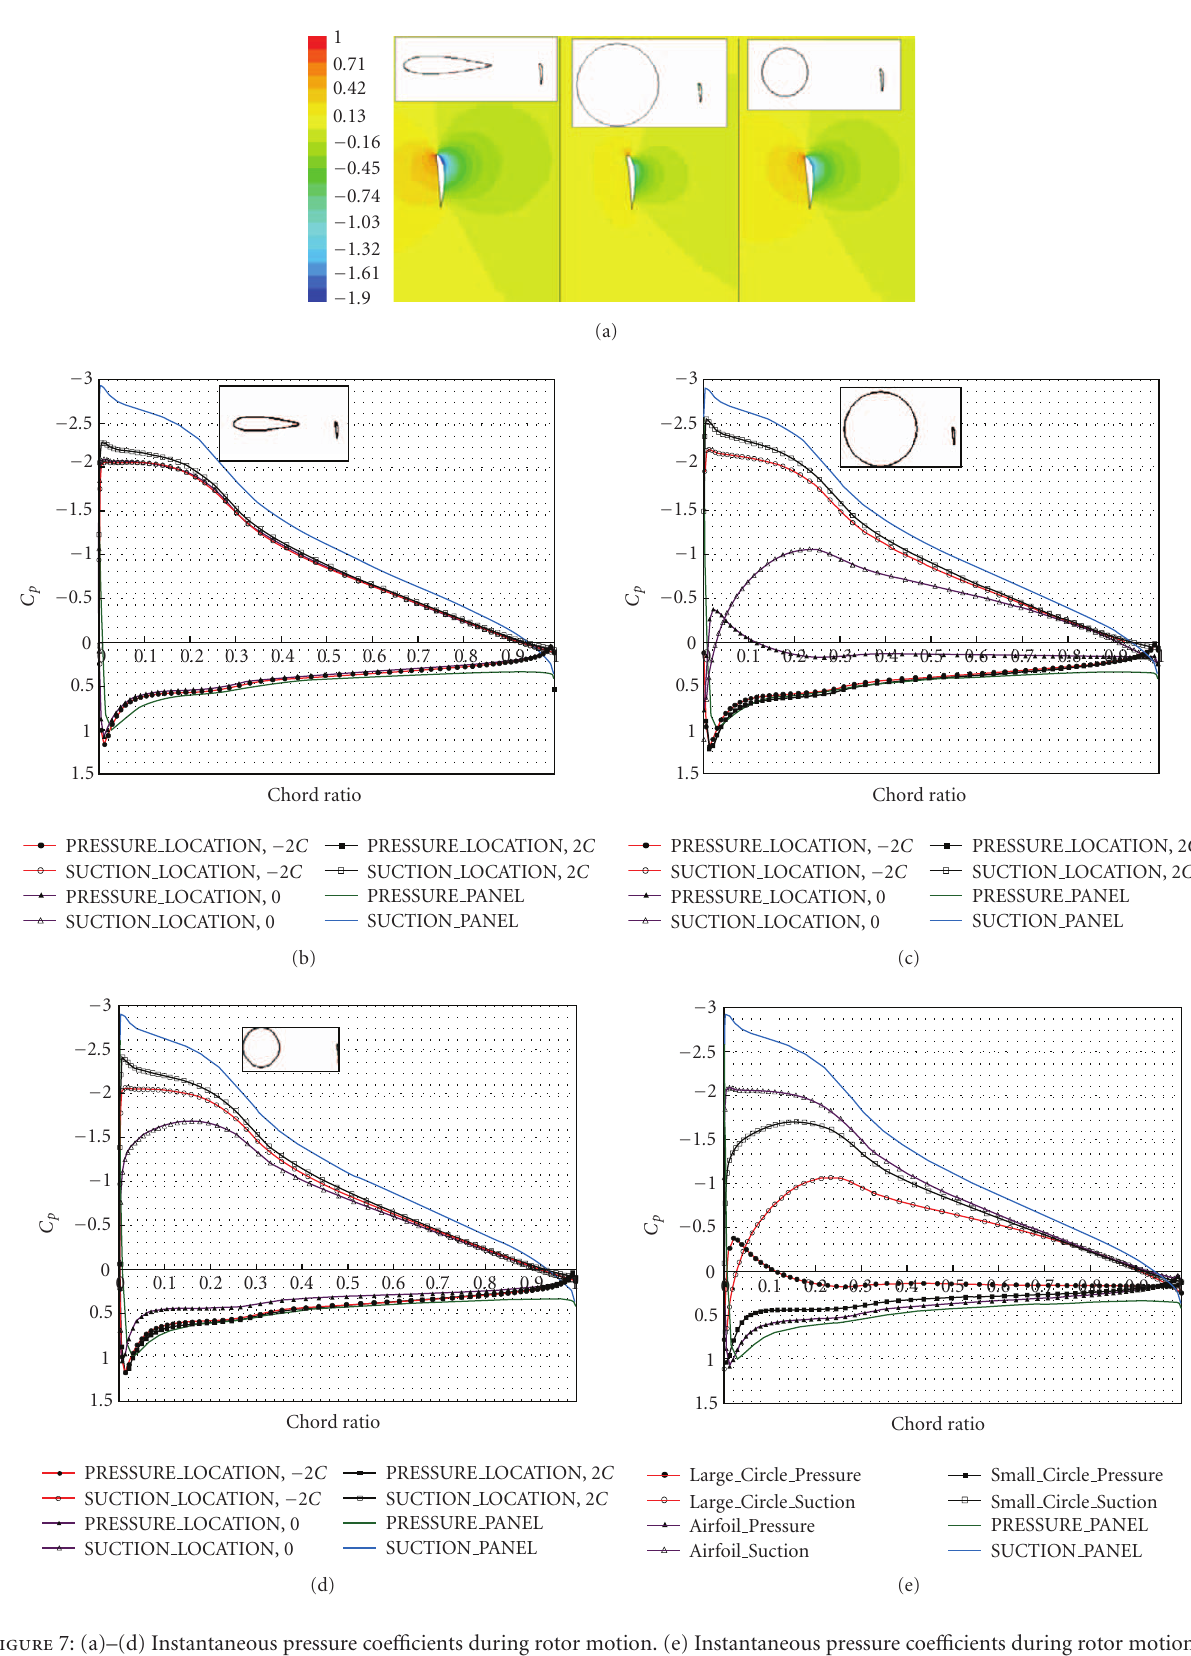
Figure 7: (a)–(d) Instantaneous pressure coe ffi cients during rotor motion. (e) Instantaneous pressure coe ffi cients during rotor motion at 0 rotor position downstream di ff erent